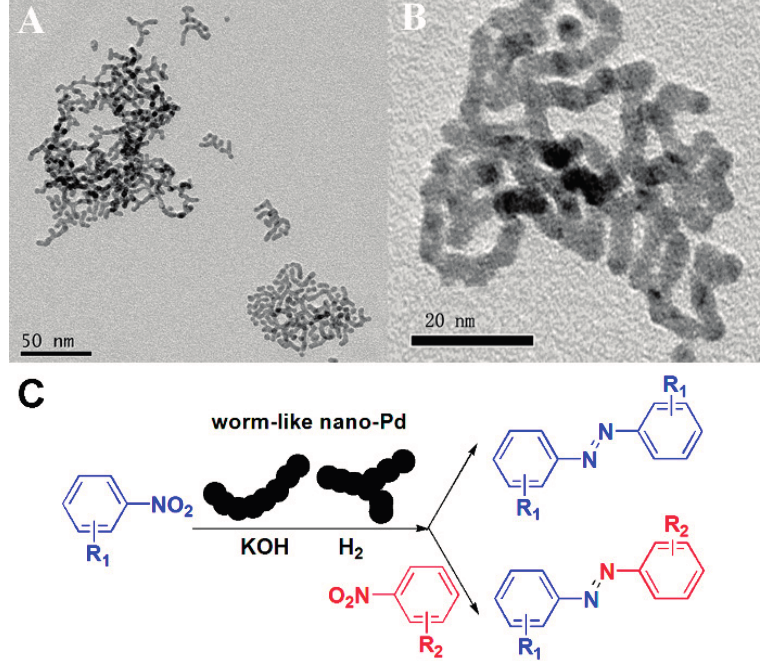
Figure 9. ( A ) The TEM image of worm-like Pd nanostructures; ( B ) The high resolution TEM image of worm-like Pd nanostructures; ( C ) The formation of aromatic azo compounds using worm-like Pd nanostructures as catalysts